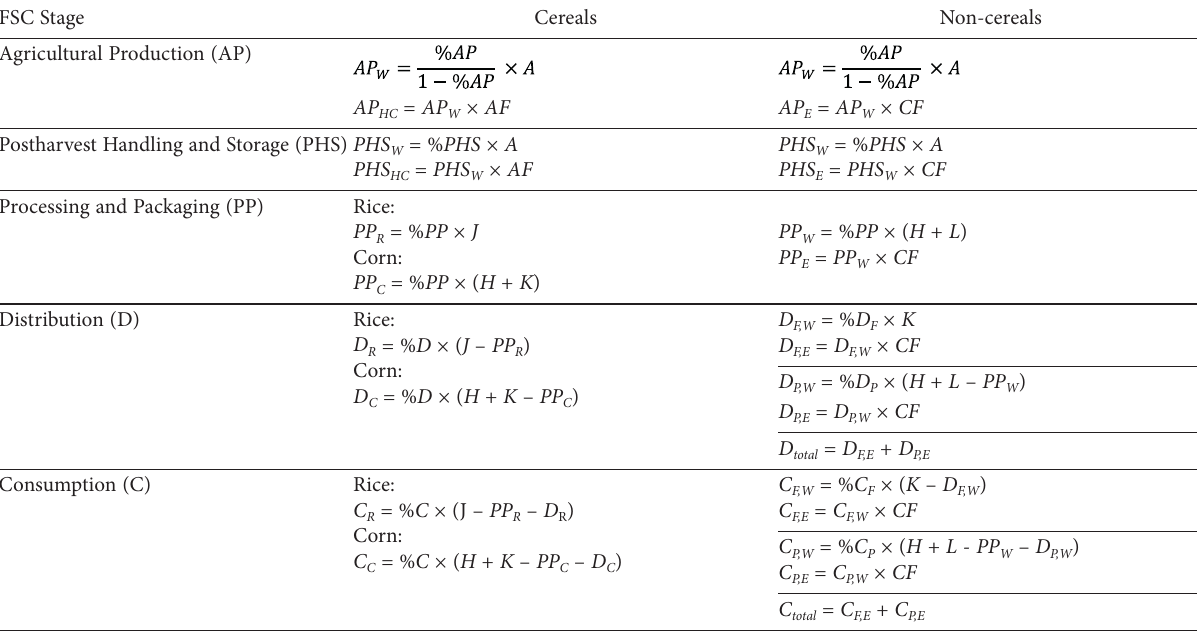
Table 2. Estimation guide for the volume of FLW generated at each FSC stage and by crop.